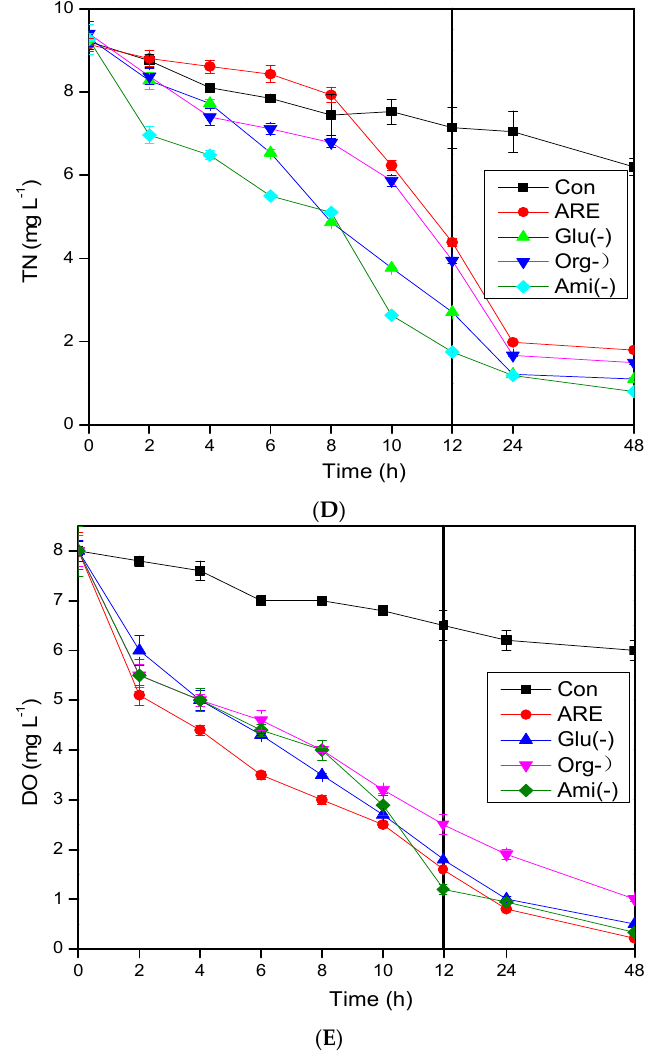
Figure 1. Average (±sd) concentrations of ( A ) NH 4+ -N, ( B ) NO 3 − -N, ( C ) NO 2 − -N, ( D ) TN, and ( E ) DO in the five different CWs during the 15th period. Con, ARE, Glu(–), Org(–) and Ami(–) were different exudate treatments, symbolic meaning was from Table 1.